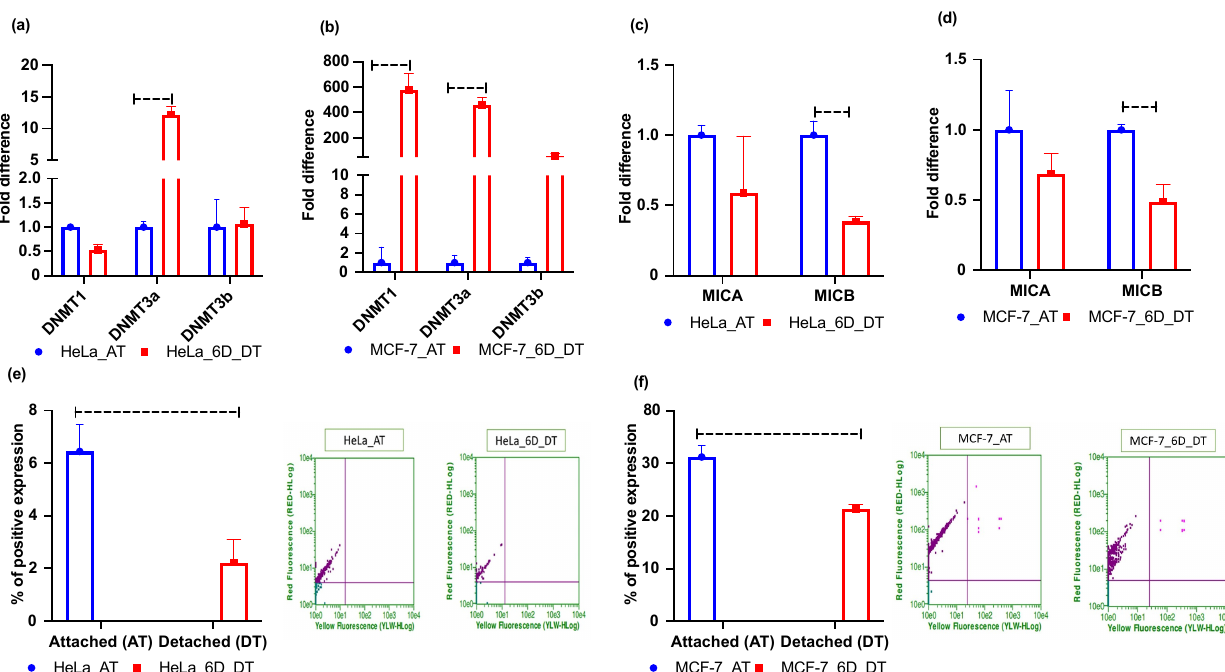
Figure 3. ECM detachment represses NKG2DLs–MICA/B expression. ( a ) Fold changes in mRNA expression of DNMT s in attached (AT) and 6 days ECM-detached (6D_DT) HeLa cell lines. ( b ) Fold changes in mRNA expression of DNMT s in attached (AT) and 6 days ECM-detached (6D_DT) MCF-7 cell lines. ( c ) Fold changes in mRNA expression of MICA/B in attached (AT) and 6 days ECM-detached (6D_DT) conditions in HeLa cell lines. ( d ) Fold changes in mRNA expression of MICA/B in attached (AT) and 6 days ECM-detached (6D_DT) conditions in MCF-7 cell lines. ( e , f ). MICA/B surface expression is repressed in the 6 days ECM-detached (6D_DT) condition compared to the attached (AT) condition in HeLa and MCF-7 cell lines. The data are presented as mean ± SEM; ns, not significant.